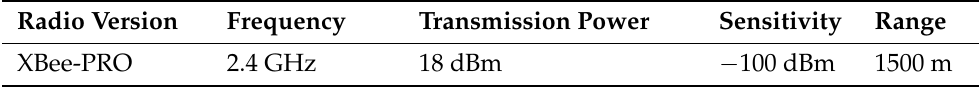
Figure 5. XBee-PRO wireless module. Table 3. XBee-PRO technical